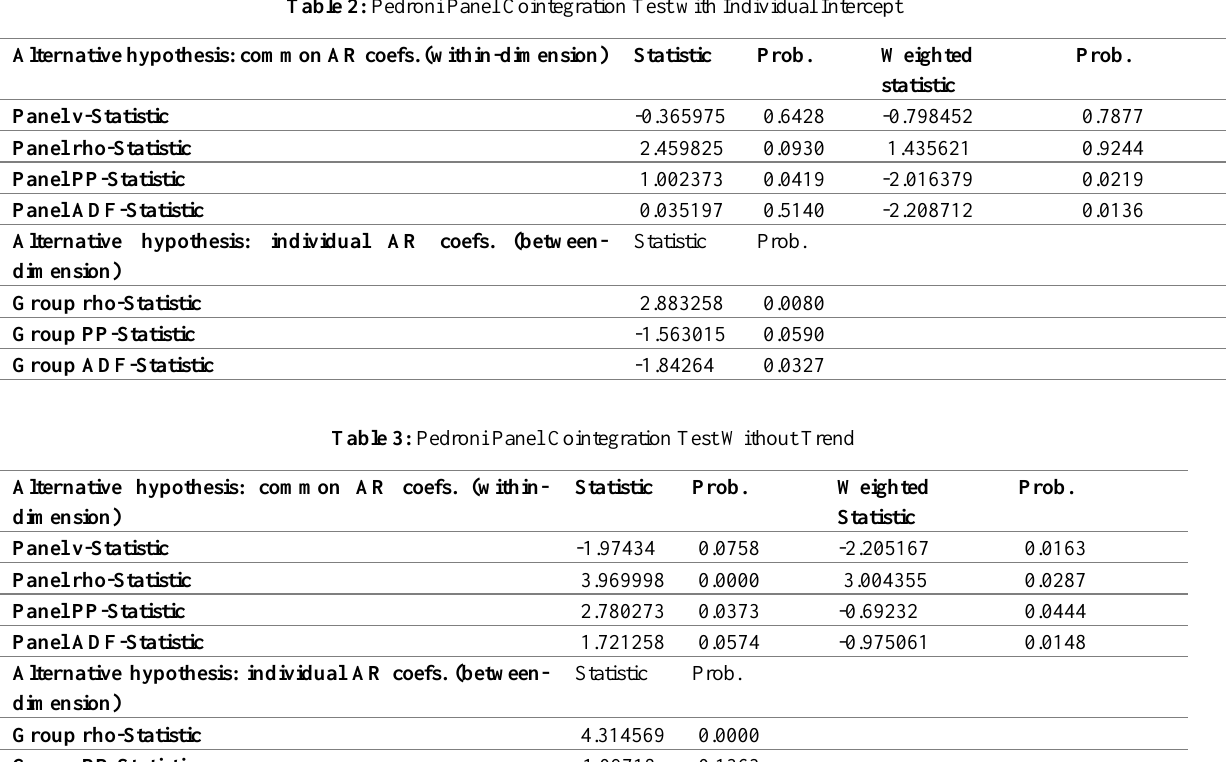
Table 2: Pedroni Panel Cointegration Test with Individual Intercept